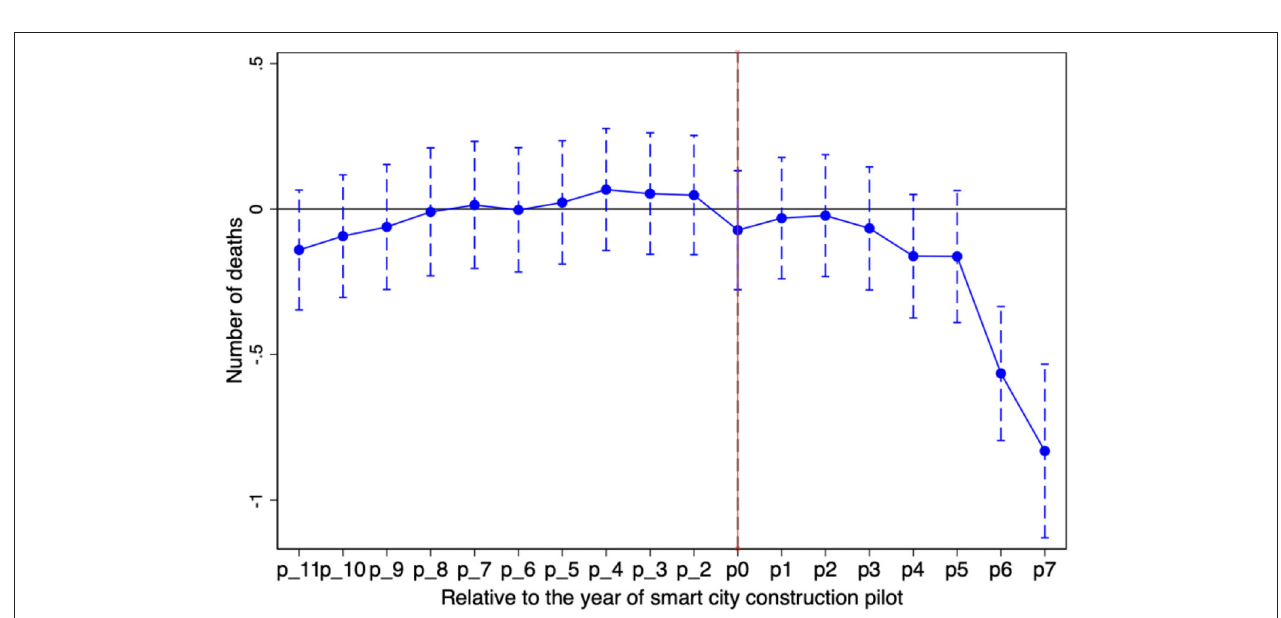
FIGURE 4 | The result of dynamic effects (number of